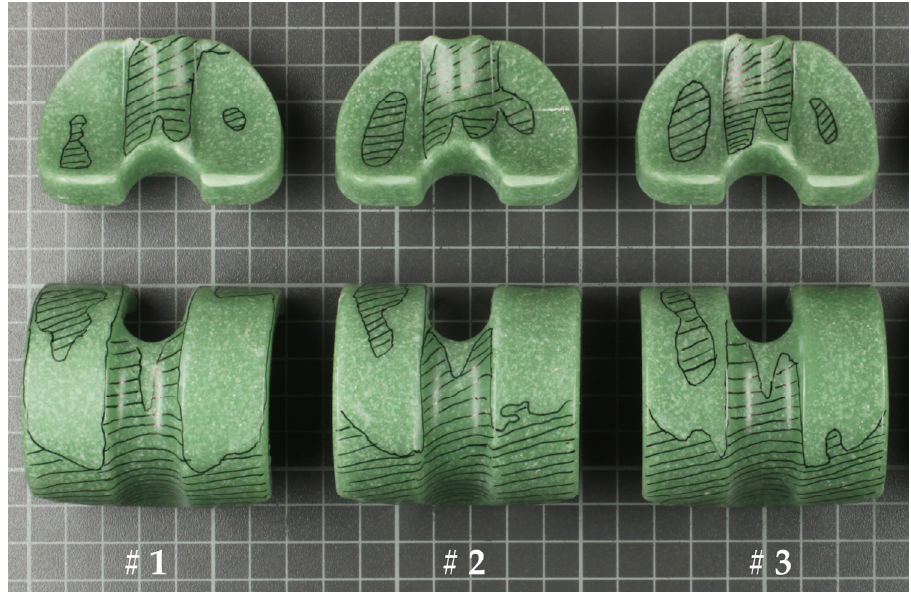
Figure 3. Worn areas of the three (#1–#3) tested CC-cement specimens.